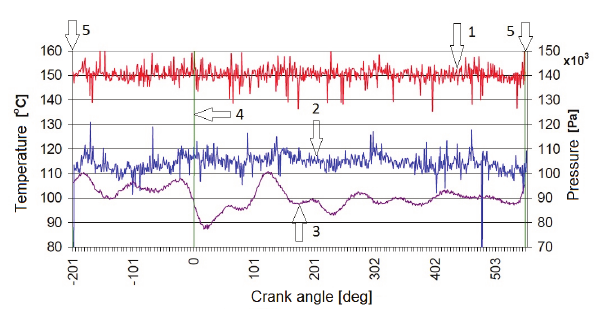
Fig. 3. Curves of the temperature changes recorded in the exhaust channel of the Farymann D10 engine with two type K thermocouples during a single work cycle: 1 – temperature recorded with the exposed thermo- couple, 2 – temperature recorded with the water-cooled thermocouple, 3